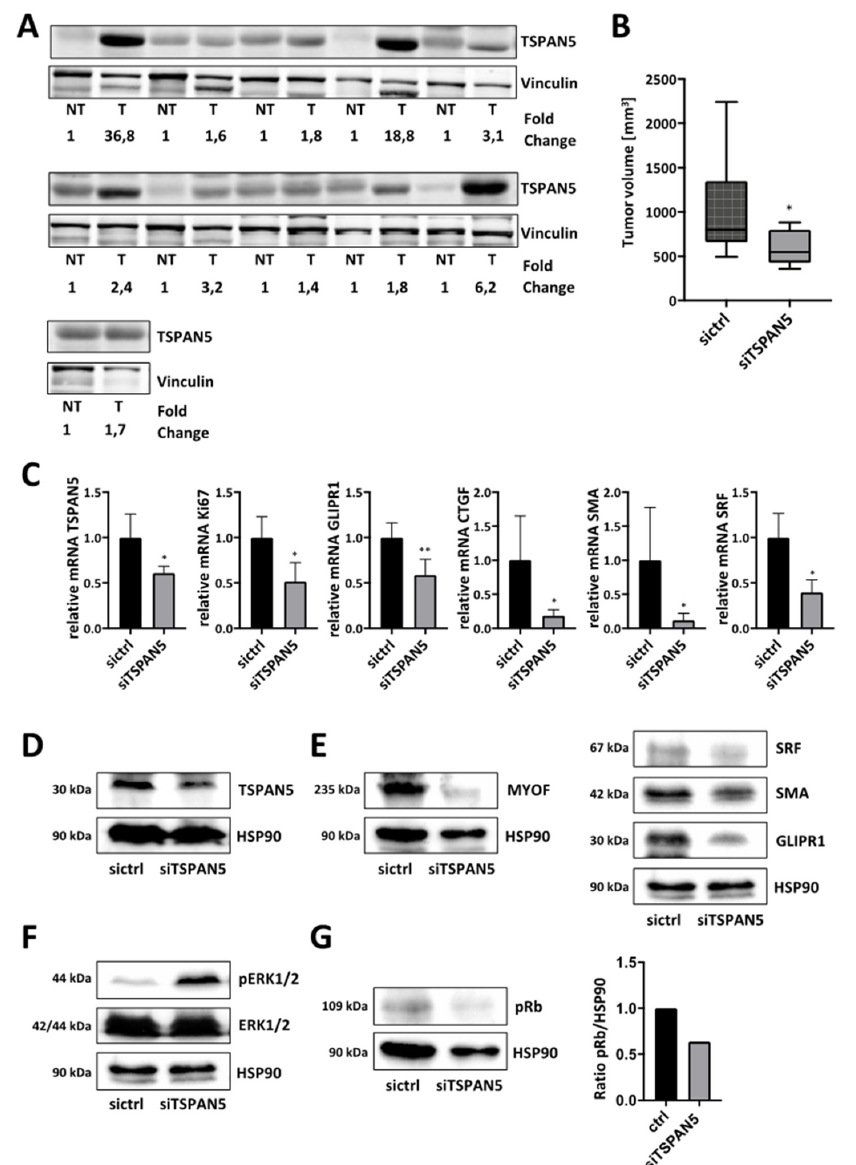
Figure 7. Anti-tumor effects of TSPAN5 depletion in xenografts. ( A ) Tissue samples of HCC patients were immunoblotted with anti-TSPAN5 antibodies and anti-vinculin antibody as a loading control. Relative fold changes of TSPAN5 protein expression (normalized to vinculin) between each pair of corresponding non-tumorous (set to 1) and tumorous tissue are indicated. ( B ) HuH7 HCC- xenograft-bearing mice were randomized and treated on day two, four, six and eight by systemic injection with polymeric nanoscale complexes containing TSPAN5 siRNA (siTSPAN5) or ctrl siRNA (sictrl). Tumor growth was measured manually. Means of tumor sizes are shown for the control and treated groups after day nine of treatment start. Data are presented as means ± SD ( n = 6 mice per group); *, p < 0.05. ( C ) TSPAN5 knockdown efficiency, Ki67 mRNA expression and MRTF target gene expression of GLIPR1 , CTGF , SMA and SRF in HCC xenografts after treatment with PEI/TSPAN5 siRNA (siTSPAN5) vs. PEI/control siRNA (sictrl), determined by qRT-PCR using the respective primers and 18S rRNA as an endogenous housekeeping gene for normalization. All data are means ± SD ( n = 5); *, p < 0.05 and **, p < 0.01. ( D – G ) Lysates of HCC xenografts treated as above were immunoblotted with anti-TSPAN5 ( D ), anti-MYOF, anti-SRF, anti-GLIPR1 ( E ), anti-ERK pT202/pY204 and anti-ERK ( F ), anti-pRb ( G ) and anti-HSP90 antibodies. The whole Wester Blots are available at Figure